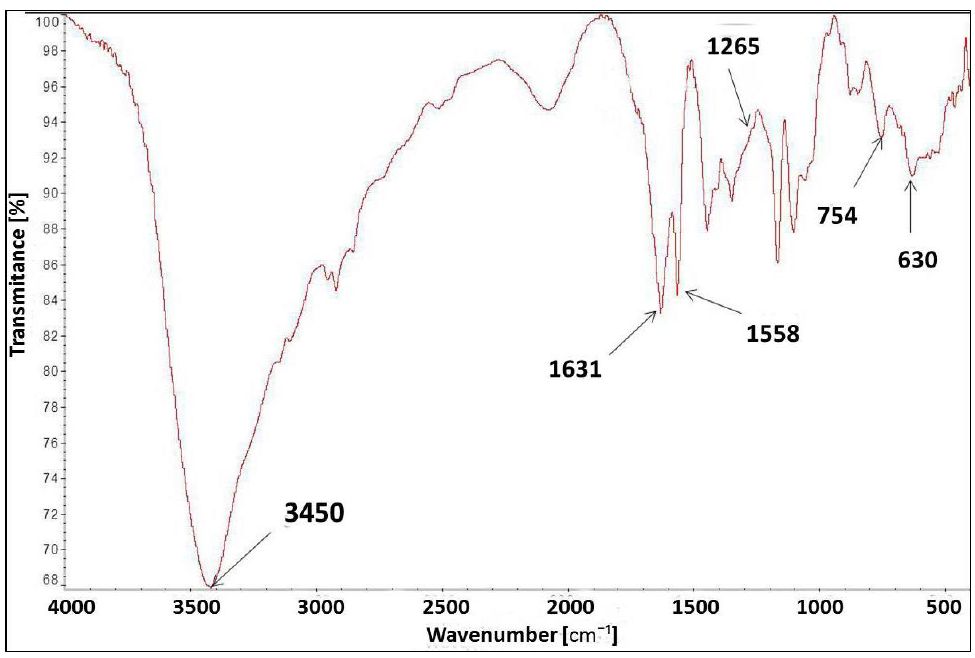
Figure 7. FT-IR spectrum for [IME] + Cl − .